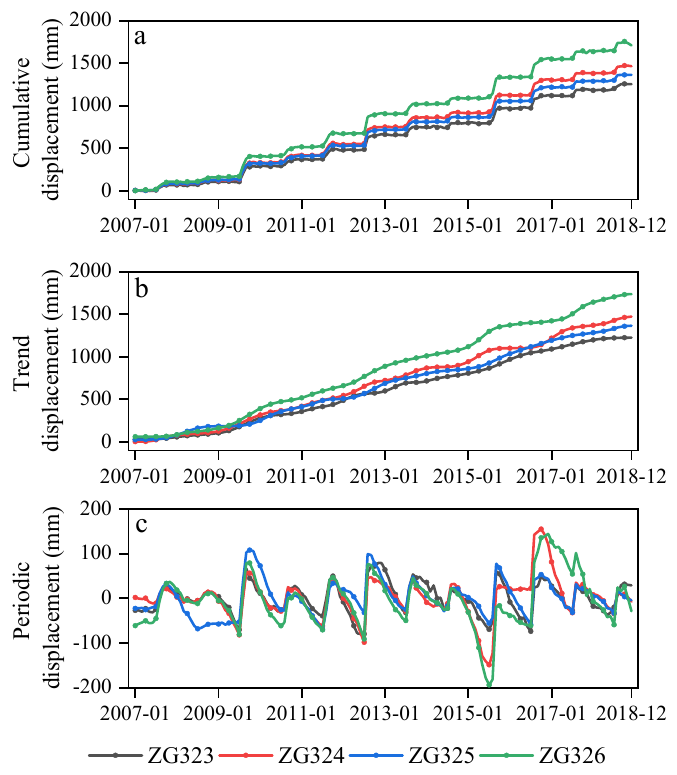
Figure 7. ( a ) Cumulative displacement of four GPS stations; ( b ) trend displacement of four GPS stations by LMD; ( c ) periodic displacement of four GPS stations by LMD.